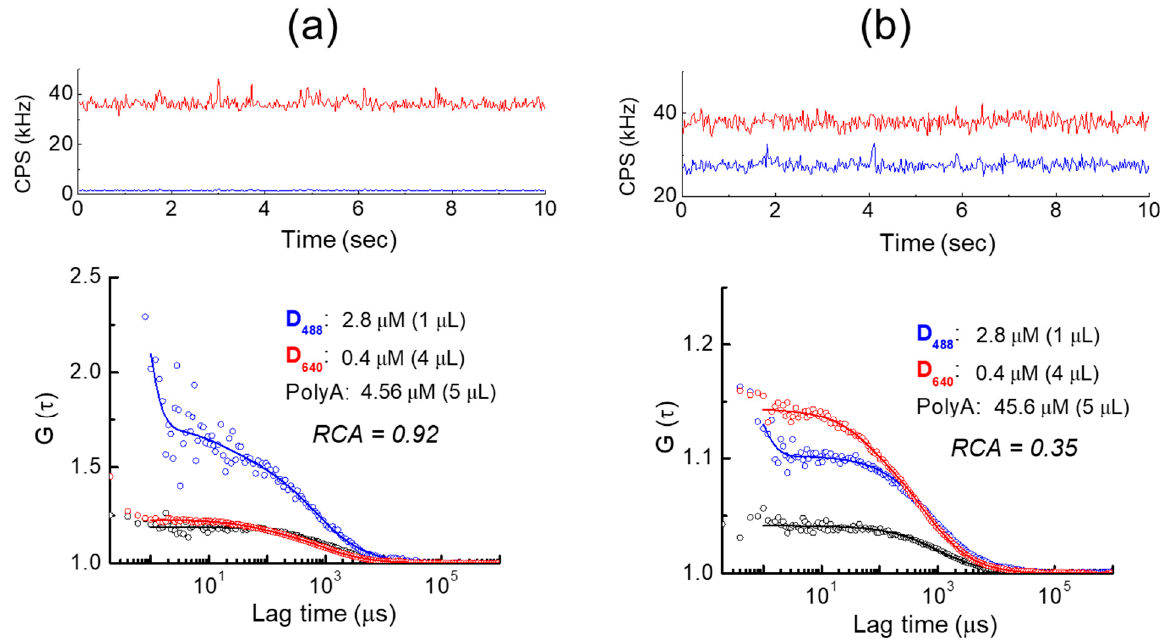
Figure 3. Detection by FCCS of the simultaneous hybridization of two different D nnn probes with poly(A) oligomers. ( a ) Representative fluorescence intensity traces (top) for a mixture of D 488 and D 640 probes with 4.56- µ M poly(A), resulting in three fluorescence correlation functions (bottom) and a relative cross-correlation amplitude (RCA) of 0.92. ( b ) Representative fluorescence intensity traces (top) for the same mixture with 45.6- µ M poly(A), resulting in fluorescence correlation functions (bottom) with similar diffusion coefficients but an RCA of 0.35. The fluorescence auto-correlation functions of D 488 and D 640 are represented in blue and red, respectively. The fluorescence cross-correlation function of the two probes is represented in black.